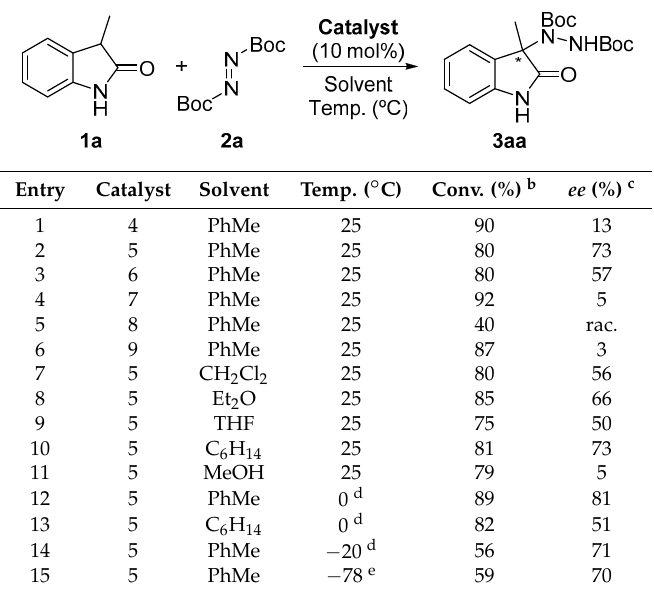
Table 1. Optimal condition screening a .